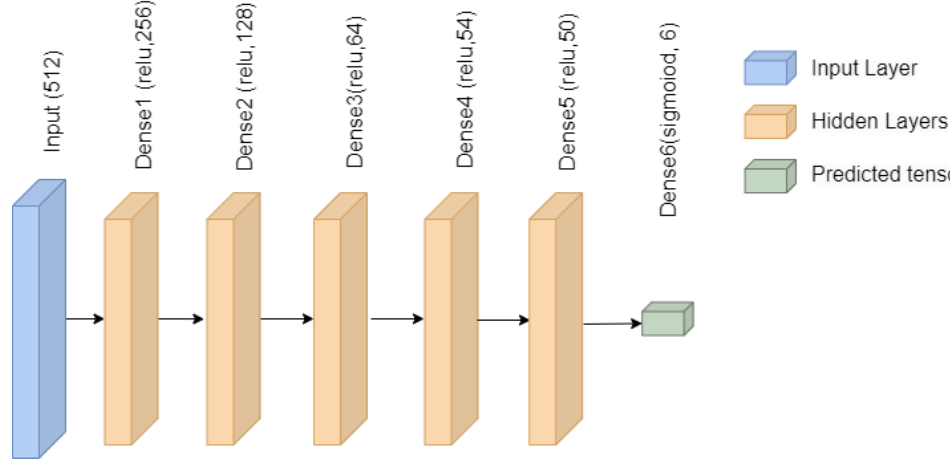
Figure 2. Deep neural network